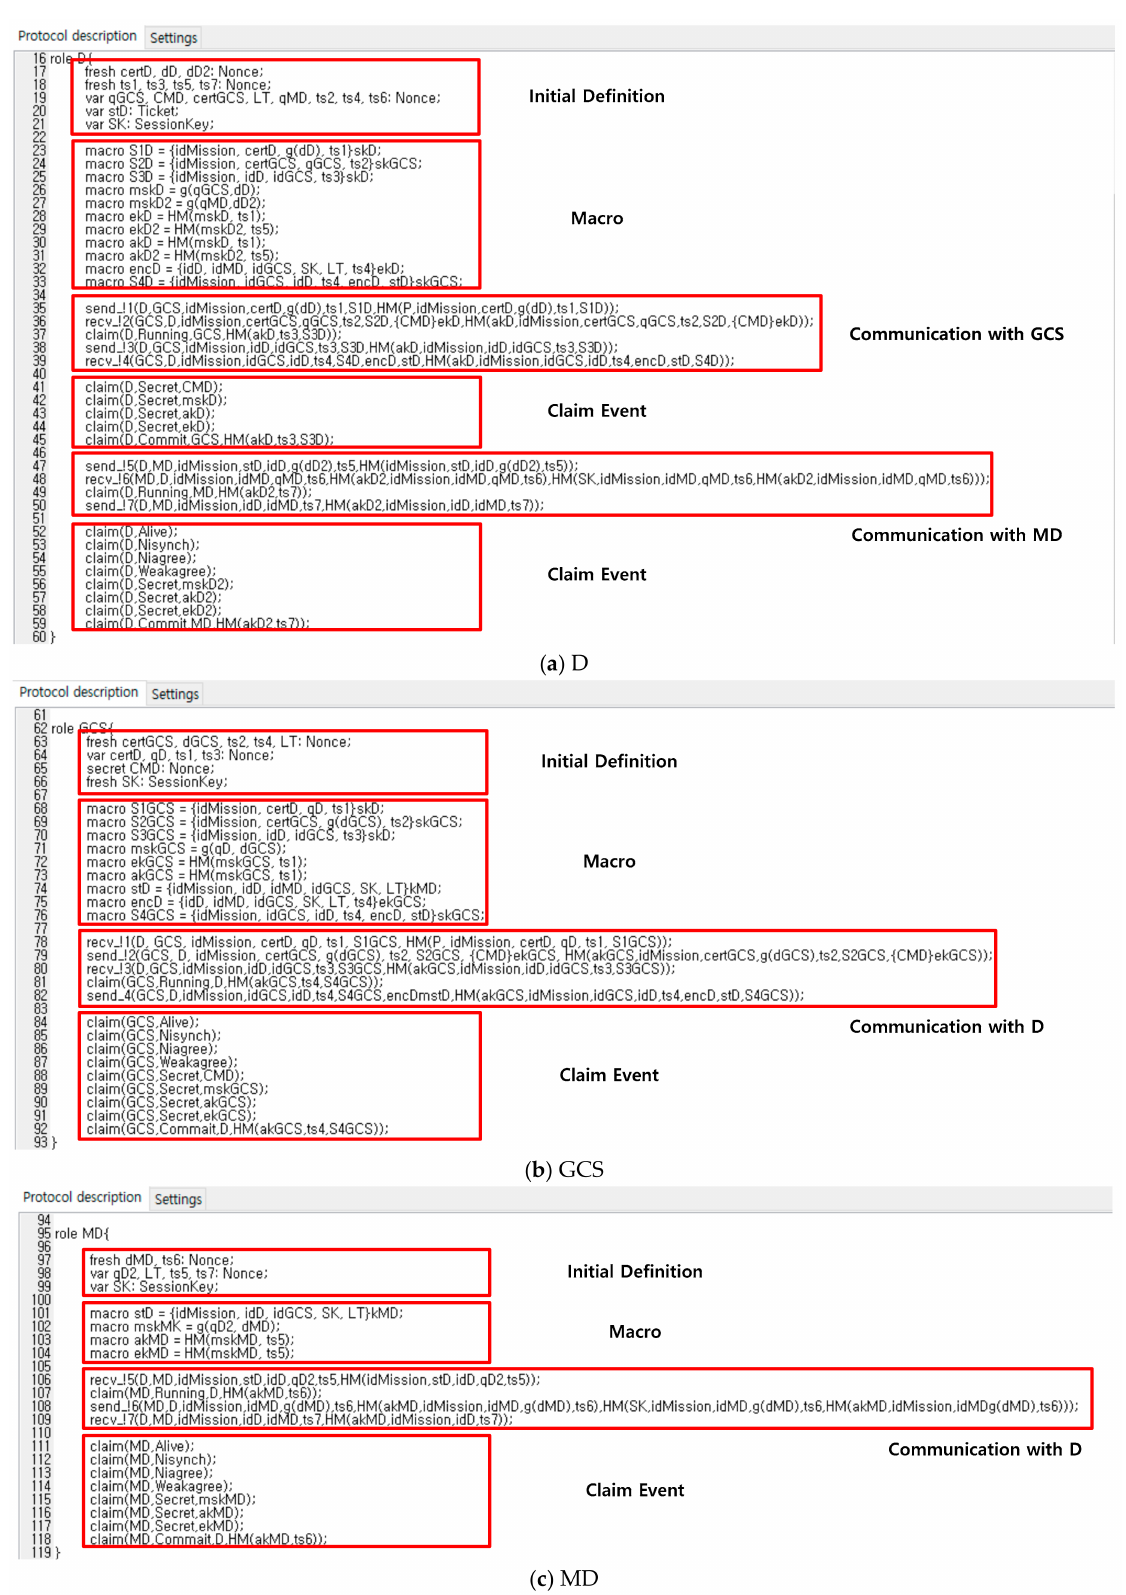
Figure 6. SPDL script of proposed protocol; ( a ) D’s SPDL script; ( b ) GCS’s SPDL script; ( c ) MD’s SPDL